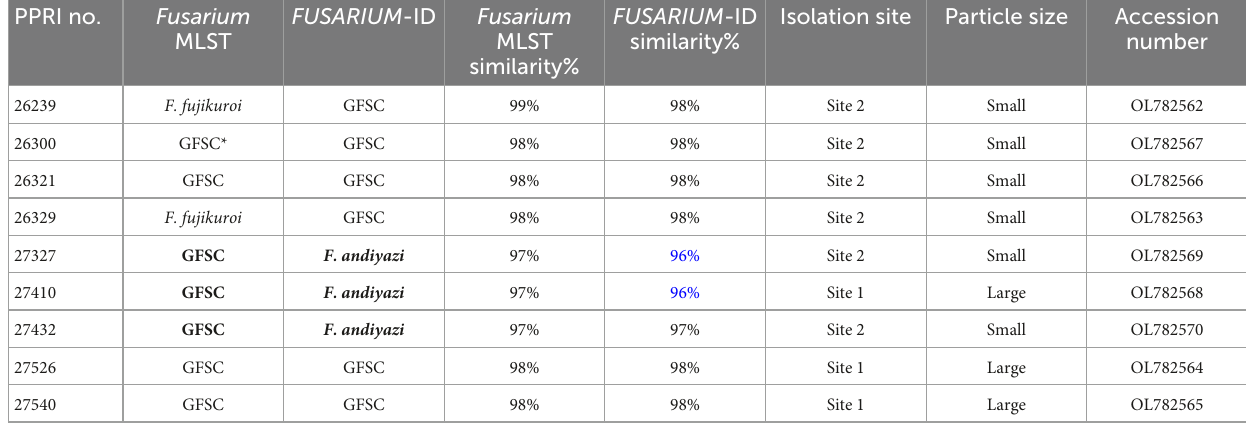
TABLE 5 Nucleotide BLAST (nBLAST TM ) results from the Fusarium MLST and FUSARIUM -ID databases for the FFSC. PPRI no.